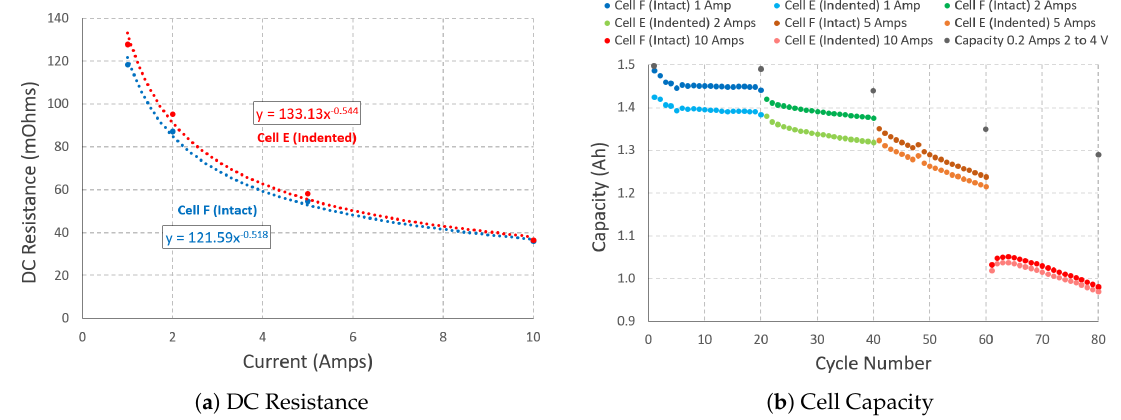
Figure 7. Testing batteries at high C-rates: ( a ) DC Resistance, ( b ) Capacity change over cycle number.